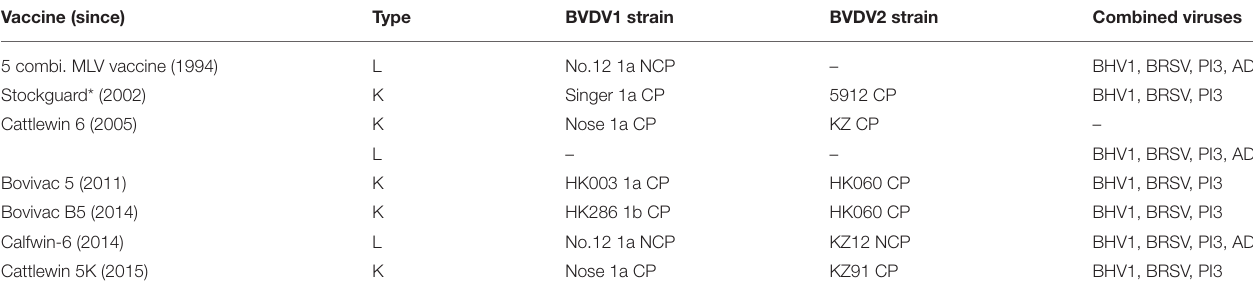
TABLE 1 | Commercially available vaccines for BVDV in Japan in 2020. Vaccine